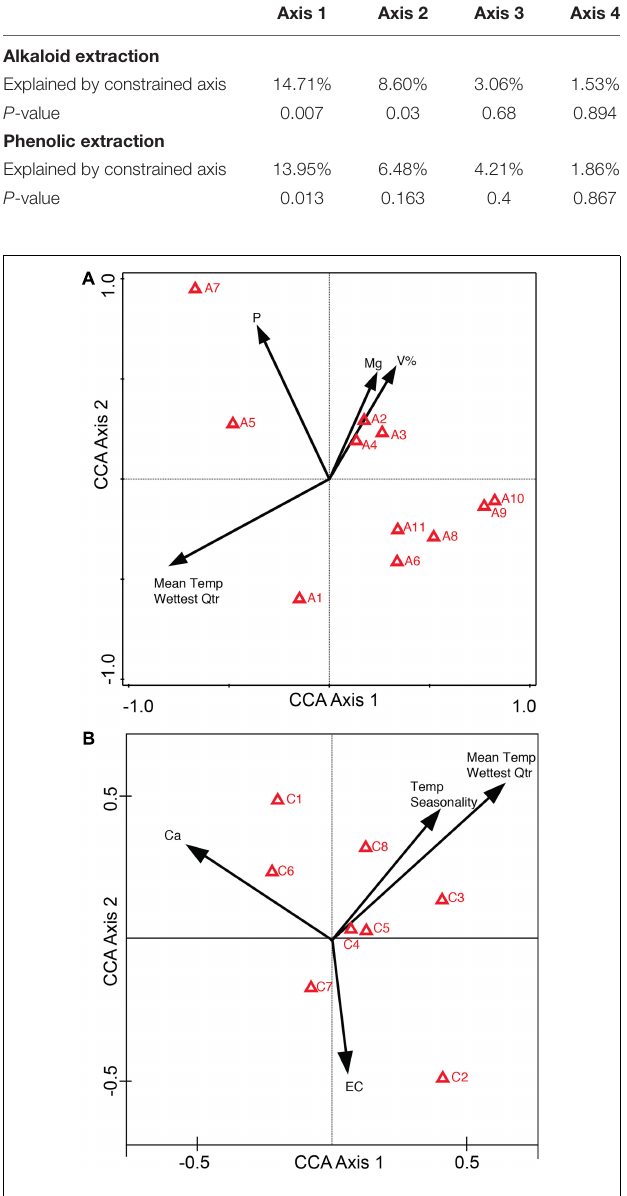
FIGURE 2 | Compounds-environmental variables biplot of Canonical Correspondence Analysis (CCA) for identified compounds. CCA biplot depicts environmental variables as arrows and compound optima as red triangles (IDs refer to Supplementary Tables 4 , 6 ). From the ordination one can determine how higher levels of environmental variables affect the abundance of the compound. Compound A7’s optima, or the highest abundance of A7, occurs at higher levels of soil P, whereas compound A6 has a higher compound abundance with low soil P (A) CCA of alkaloid compounds (A1–A11) (B) CCA of coumarin compounds